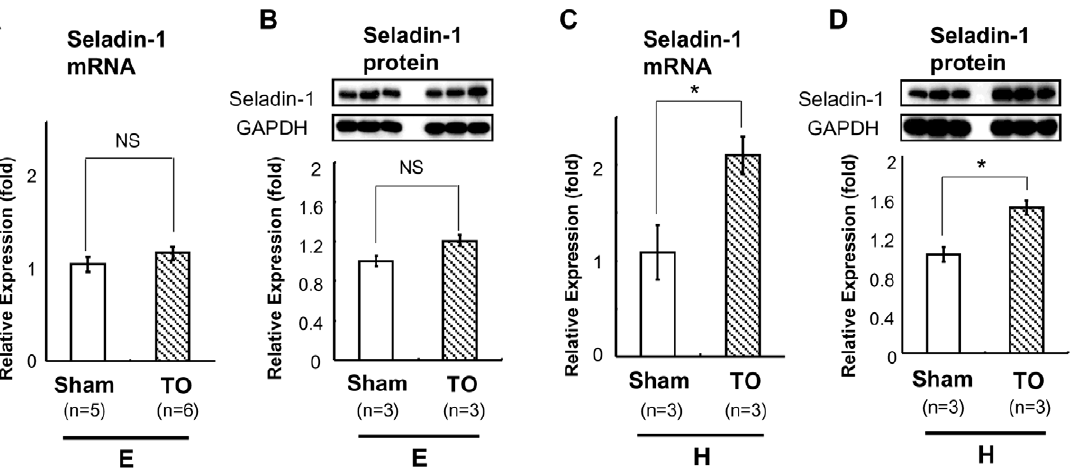
Figure 2. TO induced Seladin-1 mRNA and protein expression in the mouse forebrain in hypothyroid status. TO was administered to mice in euthyroid (E) or hypothyroid (H) status. The number of mice employed is indicated in the figures. Reverse transcription (RT) real-time PCR analysis for Seladin-1 was performed using mouse forebrain cDNA (A, C). Relative values (mean 6 S.E.) normalized by cyclophilin A mRNA levels compared with Sham are shown as relative expression (fold). Western blot analysis using mouse forebrain whole cell extract was performed (B, D). Representative Western blots for Seladin-1 are shown in the upper panel (B, D). Relative values (mean 6 S.E.) normalized by GAPDH protein levels compared with Sham are shown as relative expression (fold). An asterisk indicates that the difference between the denoted pairs is significant at a